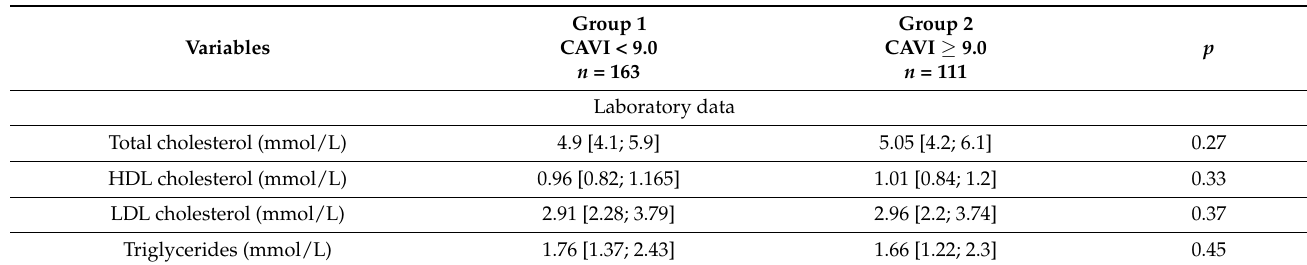
Table 2. The instrumental and laboratory parameters in groups with pathological and normal CAVI before coronary artery bypass